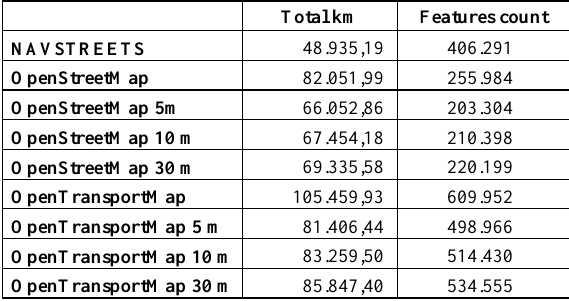
Table 2. Comparison of total km and number of features between OSM, OTM and NAVSTREETS Street Data in